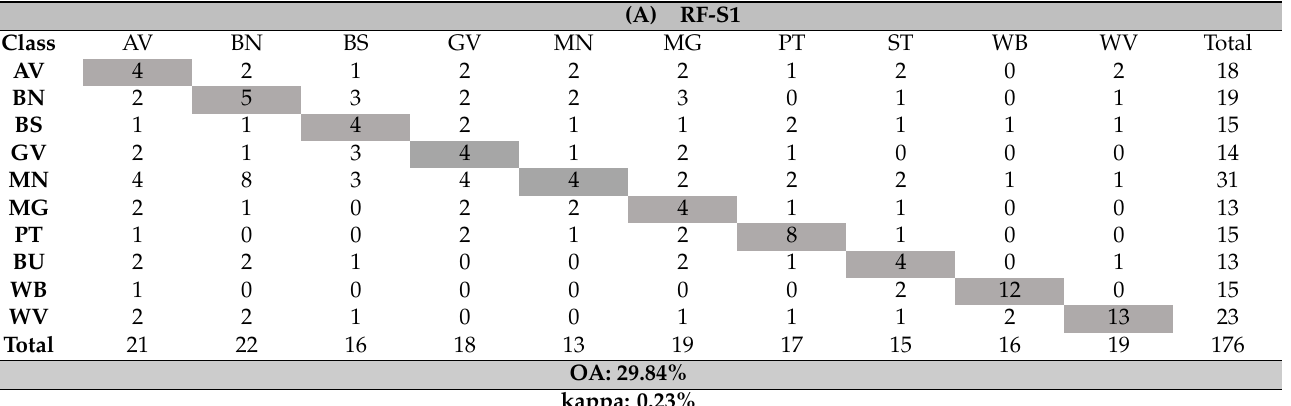
Figure 6. Mapping fruit-tree crops and other existing land use types based on Sentinel-1 data (( A ): RF, ( B ): SVM) , Sentinel-2 (( C ): RF , ( D ): SVM ), Sentinel-2 selected variables (( E ): RF, ( F ): SVM ), Sentinel-1 and Sentinel-2 (( G ): RF, ( H ): SVM ), and Sentinel-1 and Sentinel-2 selected variables (( I ): RF, ( J ): SVM ). Table 2. Confusion matrices for the models that produced the models that produced the highest overall accuracy using RF and SVM algorithms. The mapped classes are avocado (AV), banana (BN), bare soil (BS), guava (GV), macadamia nut (MN), mango (MG), pine tree (PT), built-up (BU), water body (WB), and woody vegetation